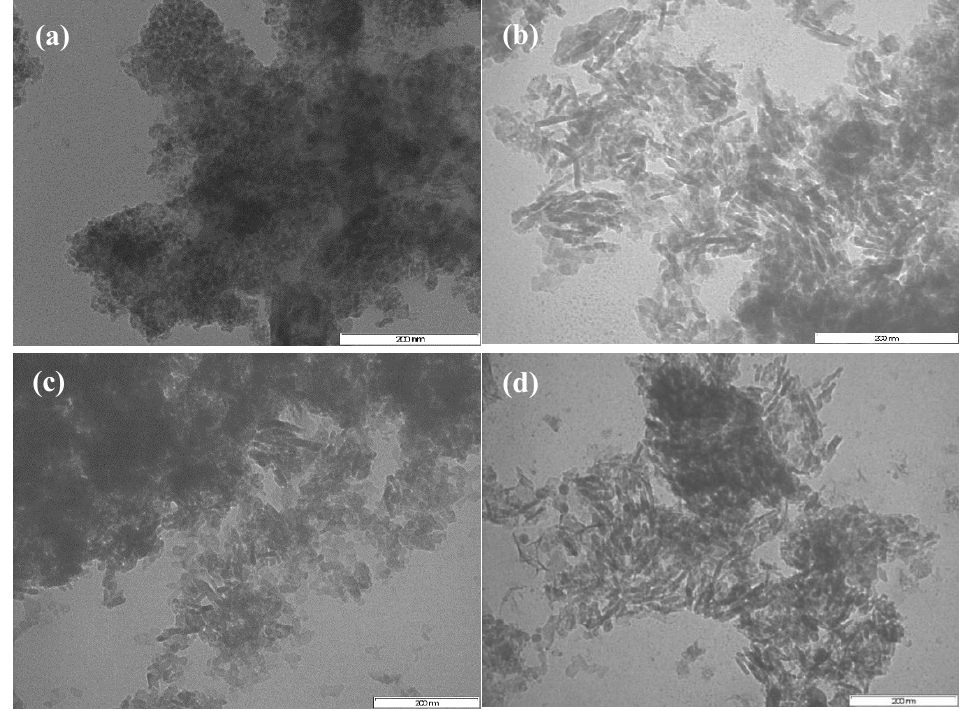
Figure 4. TEM images of ( a ) γ -Al 2 O 3 support, ( b ) 2.5% Mn / γ -Al 2 O 3 , ( c ) 5% Mn / γ -Al 2 O 3 , ( d ) 7.5% Mn / γ -Al 2 O 3 catalysts.